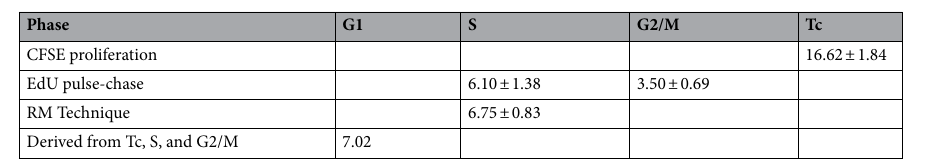
Table 1. The estimated duration (h) of each cell cycle phase and total cell cycle time (Tc) of non-irradiated T lymphocytes, determined by different methodologies. The estimated mean ± standard deviation (h) is shown.